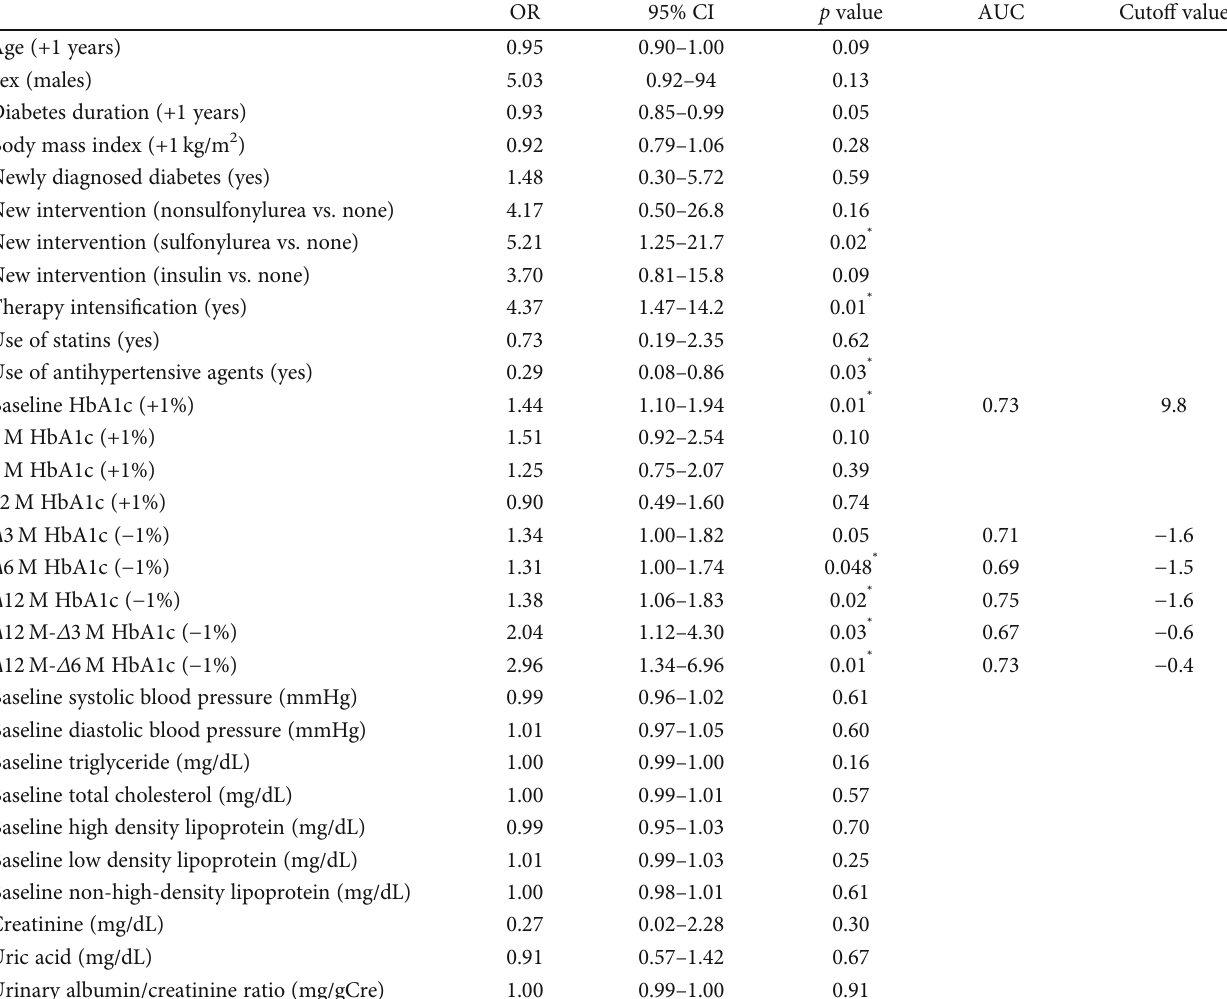
Table 2: Univariate logistic regression analysis for retinopathy progression in patients with simple diabetic